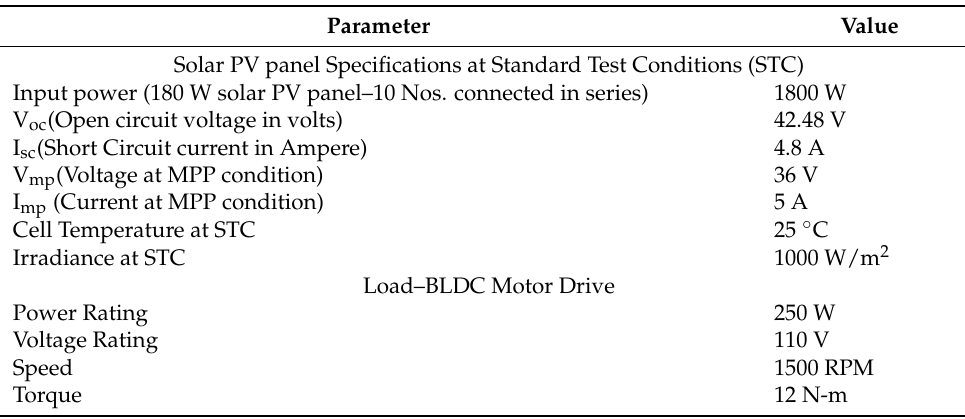
Table 2. Input and Output